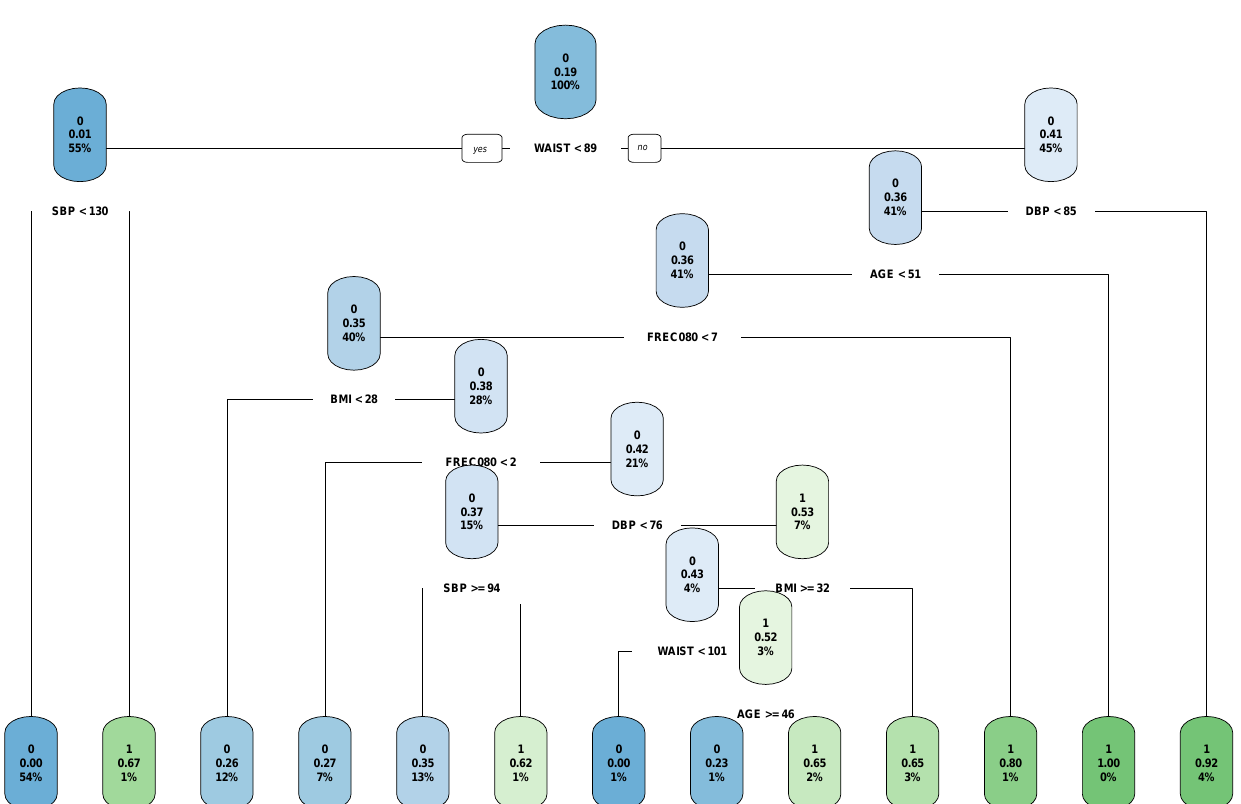
Figure 3. Best predictive model built with C4.5 for women across 30 independent